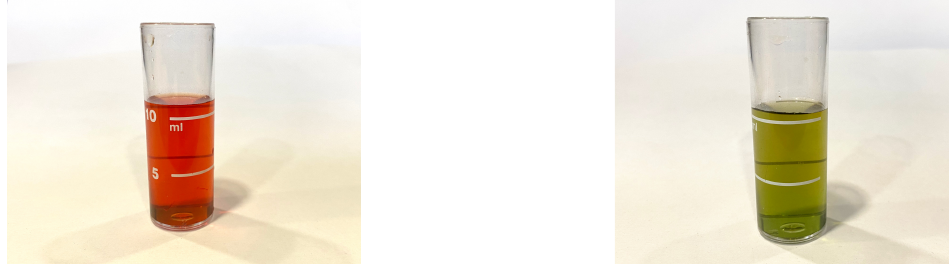
Figure 6. Titration. ( Left ): Starting point of the titration; ( Right ): Final result after colour change.